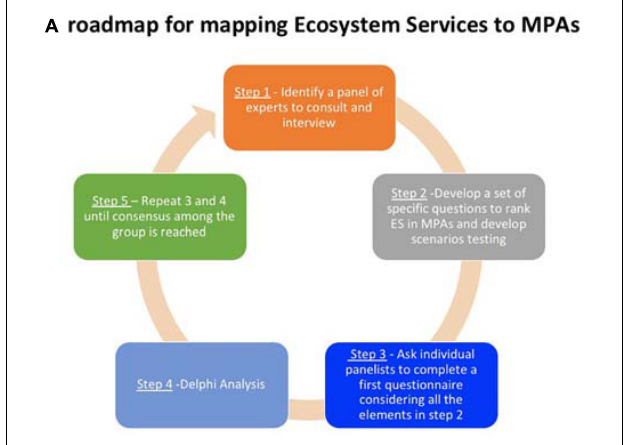
FIGURE 2 | A conceptual roadmap for mapping ecosystem services to MPAs describing the five sequential